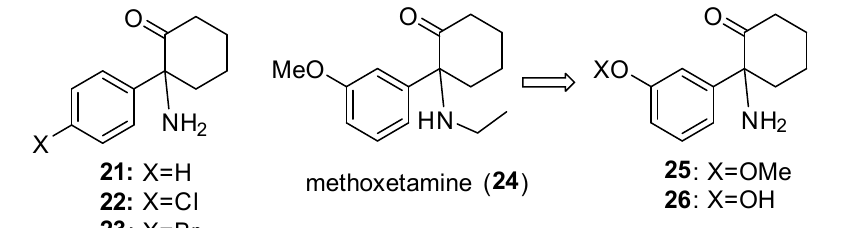
Figure 2. Known norketamine analogues.